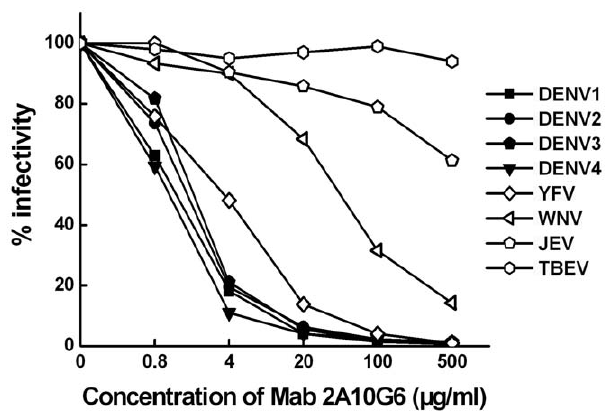
Figure 4. Neutralization activity of 2A10G6 to various flavivirus strains. Viruses were mixed with 2A10G6 at different concentrations. Neutralization activities were evaluated by plaque reduction assays using BHK21 cells.